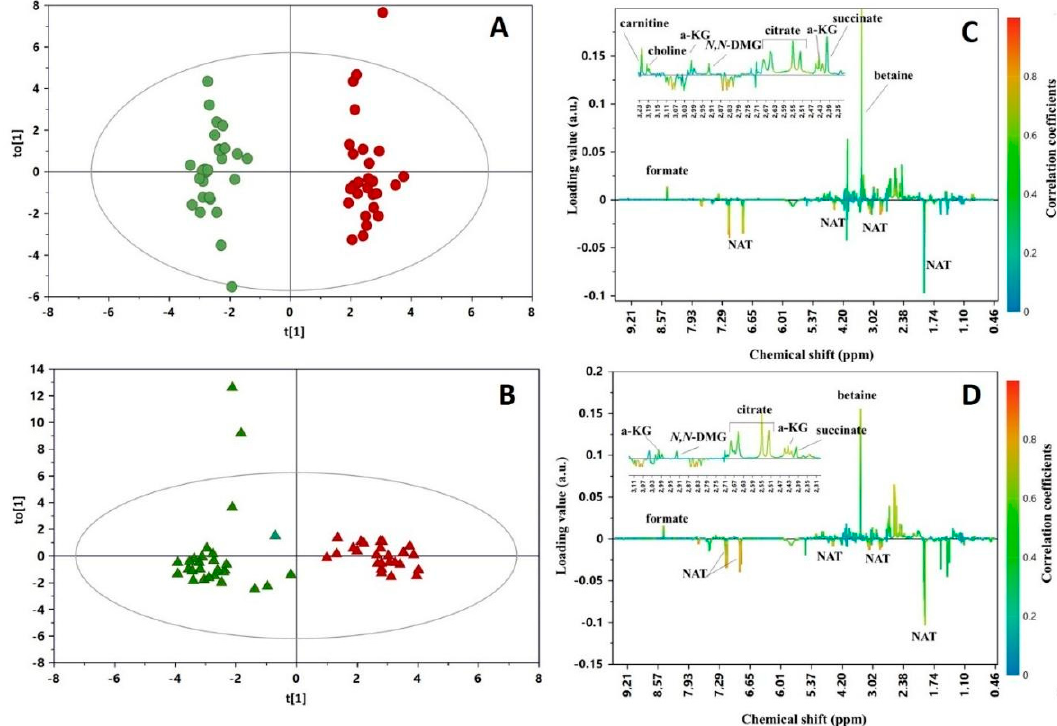
Figure 2. Scores ( left ) and S-line correlation coefficient ( right ) plots of the orthogonal partial least squares discriminant analysis ( OPLS-DA) models built with urine of B-HMF ( ● , A , B ) and D-HMF ( ▲ , C , D ) groups collected before (green, T0) and at 21 days (red, T1) from preterm infants receiving ADJ fortification. Statistical parameters of the models: ( A , B ) R 2 Y = 0.969; Q 2 =0.734; p < 0.005; ( C , D ) R 2 Y = 0.889; Q 2 = 0.786; p < 0.0001. The abbreviations used are as follow: α -KG, alpha-ketoglutarate; NAT, N -acetylthyrosine; N , N –DMG, N , N -dimethylglycine.